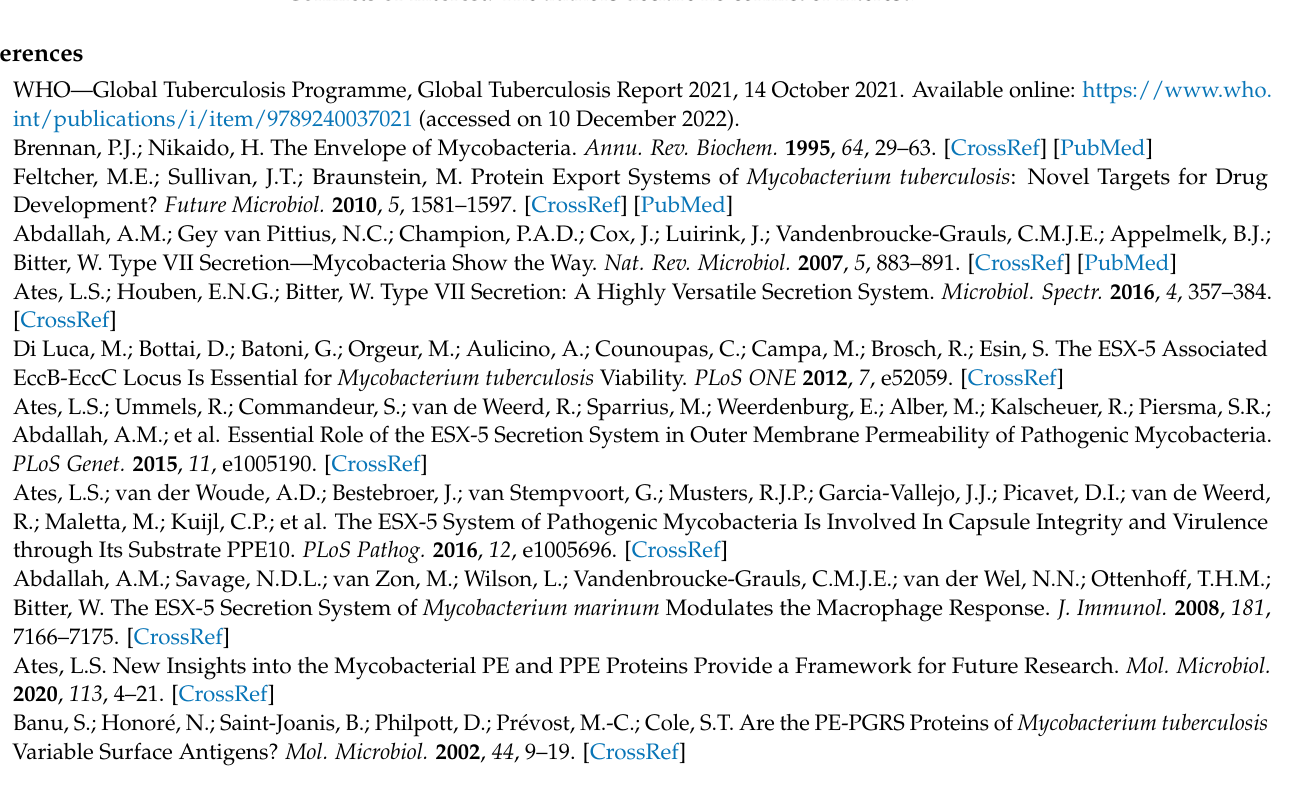
Table S2: Plasmids used in the study; Table S3: Primers used in the study